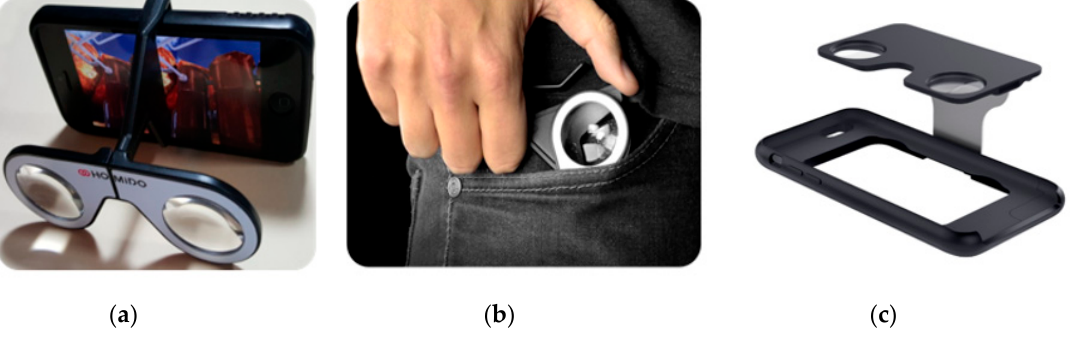
Figure 1. EasyVR with the lenses clipped onto the smartphone ( a ); detachable, foldable and easy-to-carry ( b ); and integrated into the smartphone protective casing that can easily be popped out and folded in ( c ).